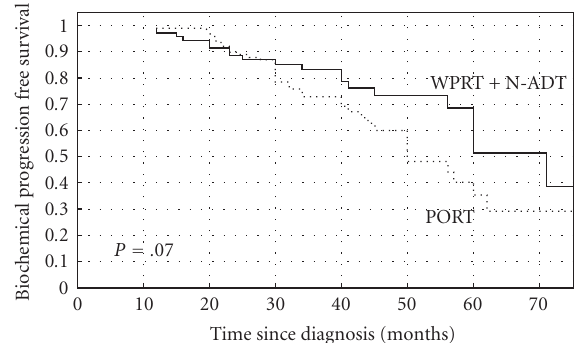
Figure 3: The Kaplan-Meier curves comparing biochemical progression-free survival (bPFS) for patients at high-risk of nodal involvement, as defined in text receiving whole pelvic radiotherapy (WPRT) combined with neoadjuvant androgen deprivation ther- apy (N-ADT) or prostate radiotherapy only (PORT), ( P = . 07).